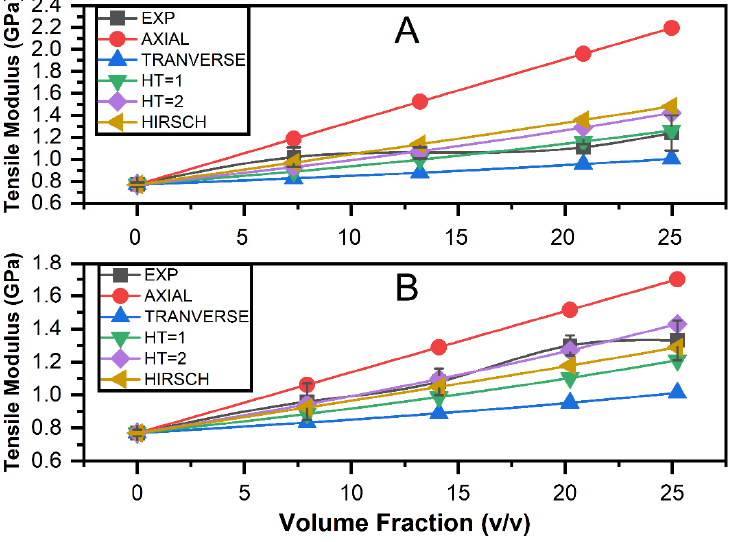
Figure 1. Modulus of versus volume fraction: ( A ) jute fibre composite ( B ) ramie fibre composite.